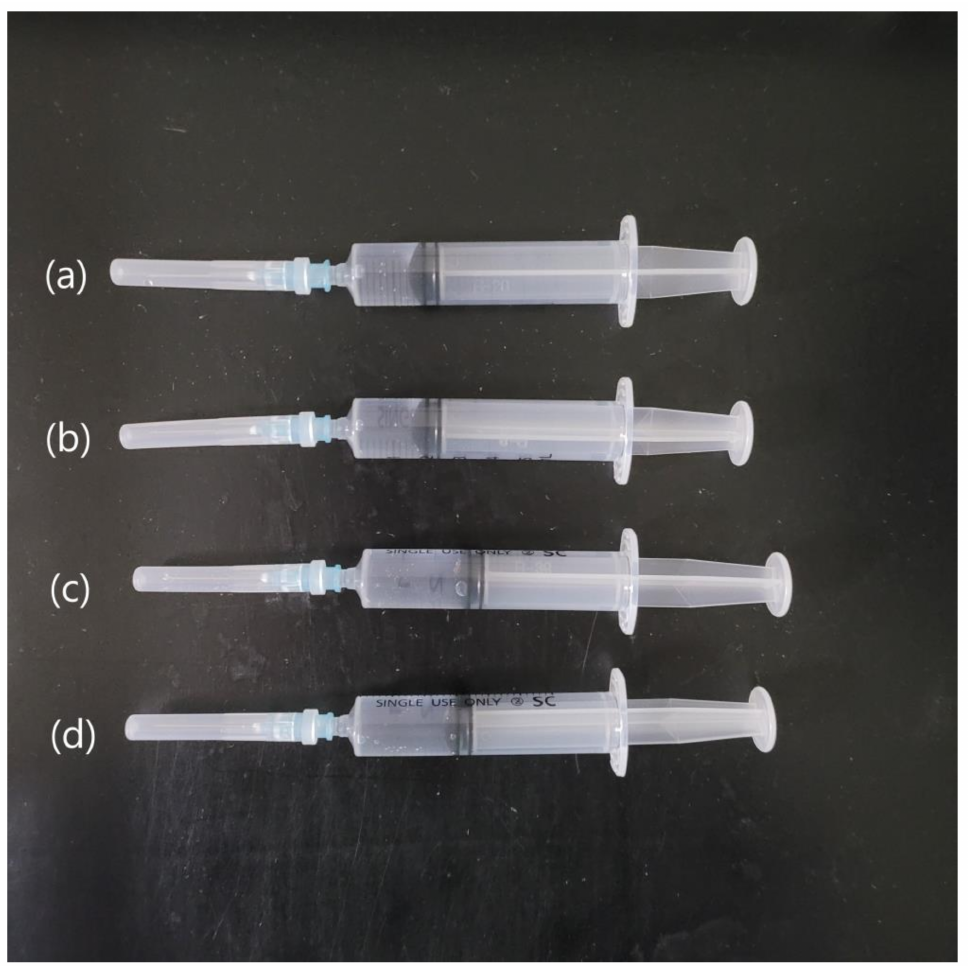
Figure 1. Macroscopic appearance of dexamethasone, ropivacaine, and contrast media. Macroscopi- cally, the mixture of non-particulate steroid and ropivacaine had a slightly cloudy appearance at all concentration. However, there were no visible particulates ( a , b ). When contrast media was mixed, it was difficult to visually confirm the difference ( c , d ). ( a ) Dexamethasone with 0.1% ropivacaine, ( b ) dexamethasone with 0.2% ropivacaine, ( c ) dexamethasone with 0.1% ropivacaine and contrast media, ( d ) dexamethasone with 0.2% ropivacaine and contrast